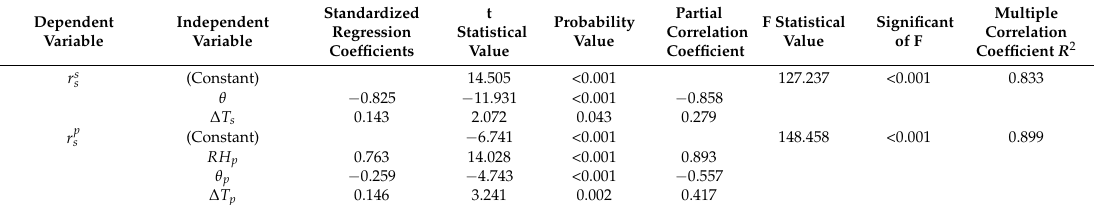
Table 4. Results of multiple stepwise regression analysis between soil surface resistance ( r s s and r p s ) and significant factors in apple season of